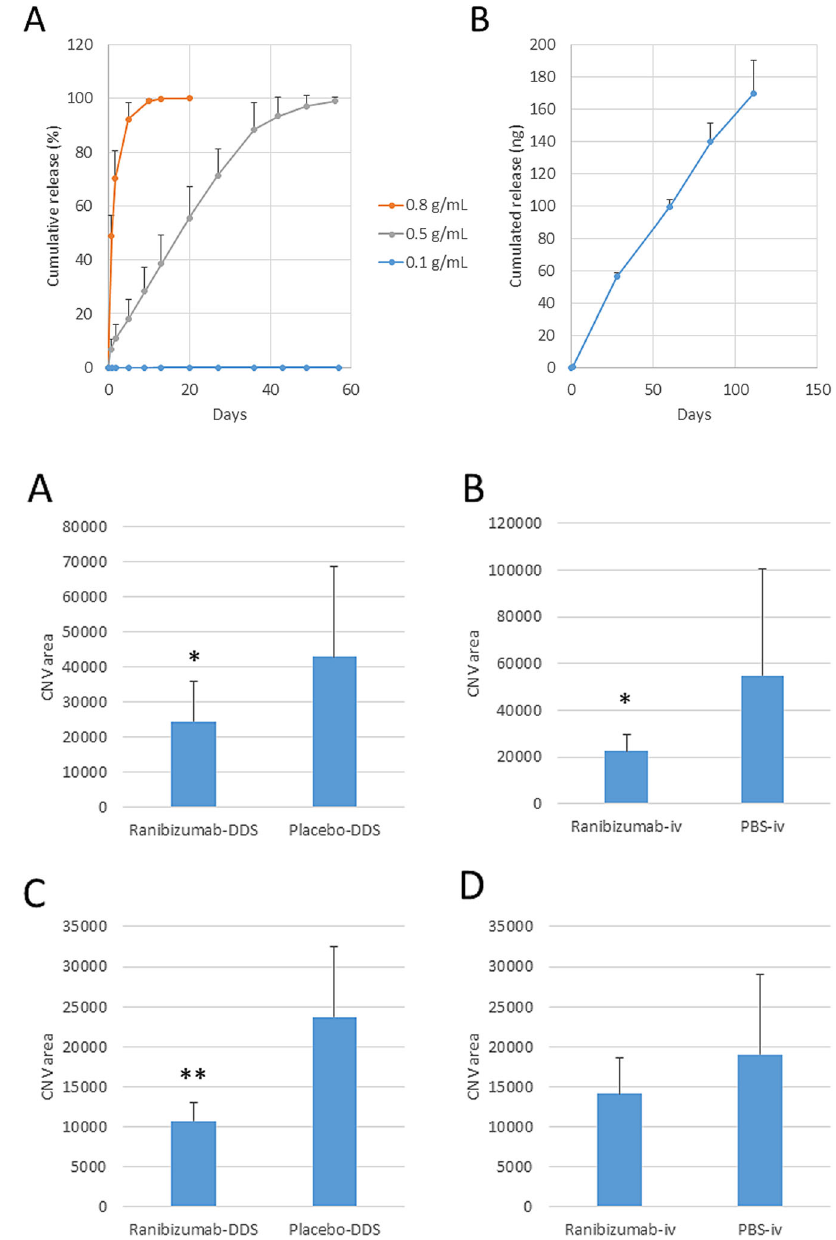
Fig. 3 A In vitro release pro fi le of FITC-albumin released from the porous PDMS sheet with NaCl particle concentration of 0.8, 0.5, and 0.1 g/mL. B In vitro release pro fi le of ranibizumab released from the porous PDMS sheet with NaCl particle concentration of 0.5 g/mL. Data points are the mean ± SD; n = 4. FITC fl uorescein isothiocyanate, PDMS poly(dimethylsiloxane), SD standard deviation